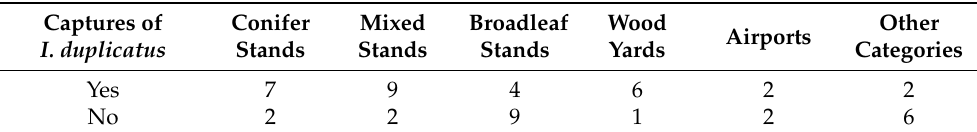
Table 3. Distribution of locations where pheromone traps for NBB were set up and its pres-